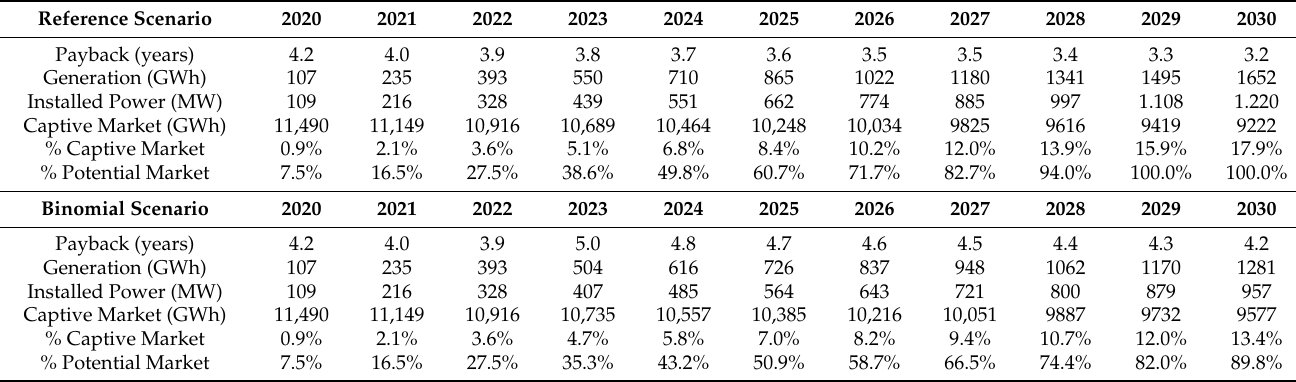
Table 8. MMDG expansion by Enel